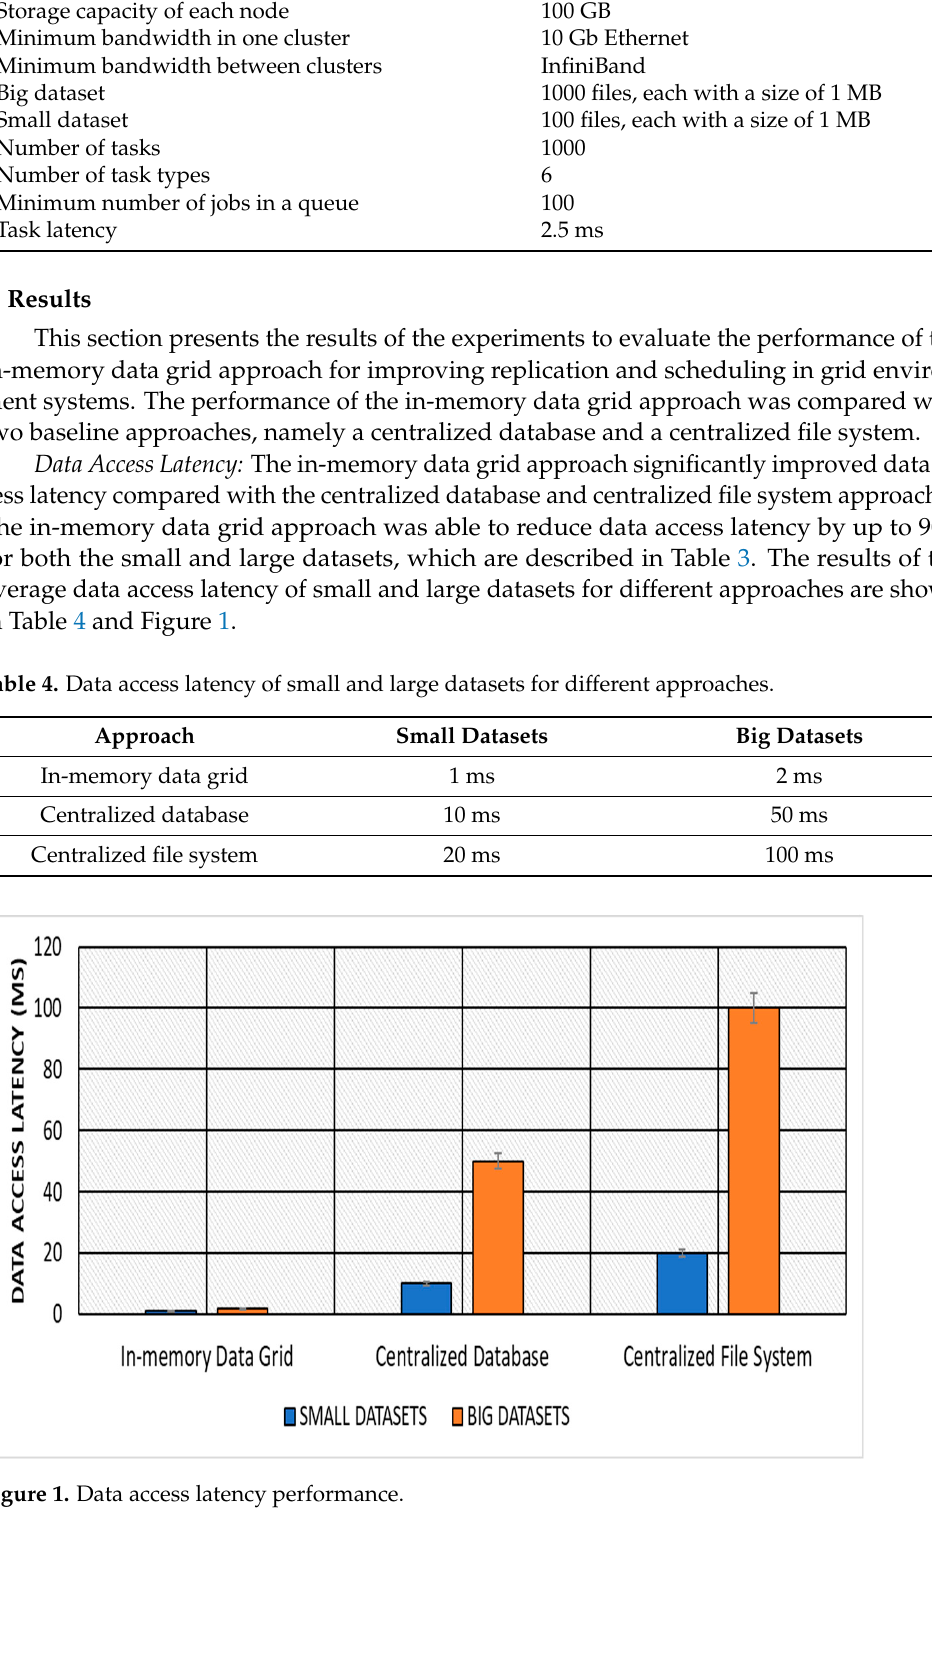
Table 3. Experimental parameter configuration.